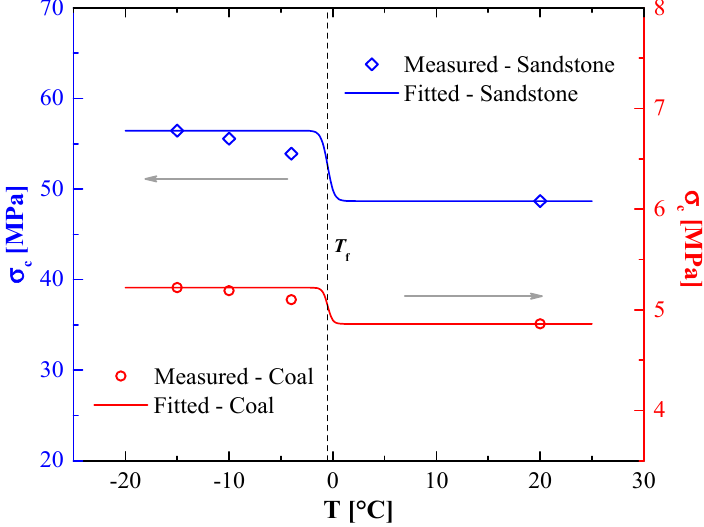
Figure 4. Uniaxial-compression strengths of sandstones and coal samples as a function of temperature.